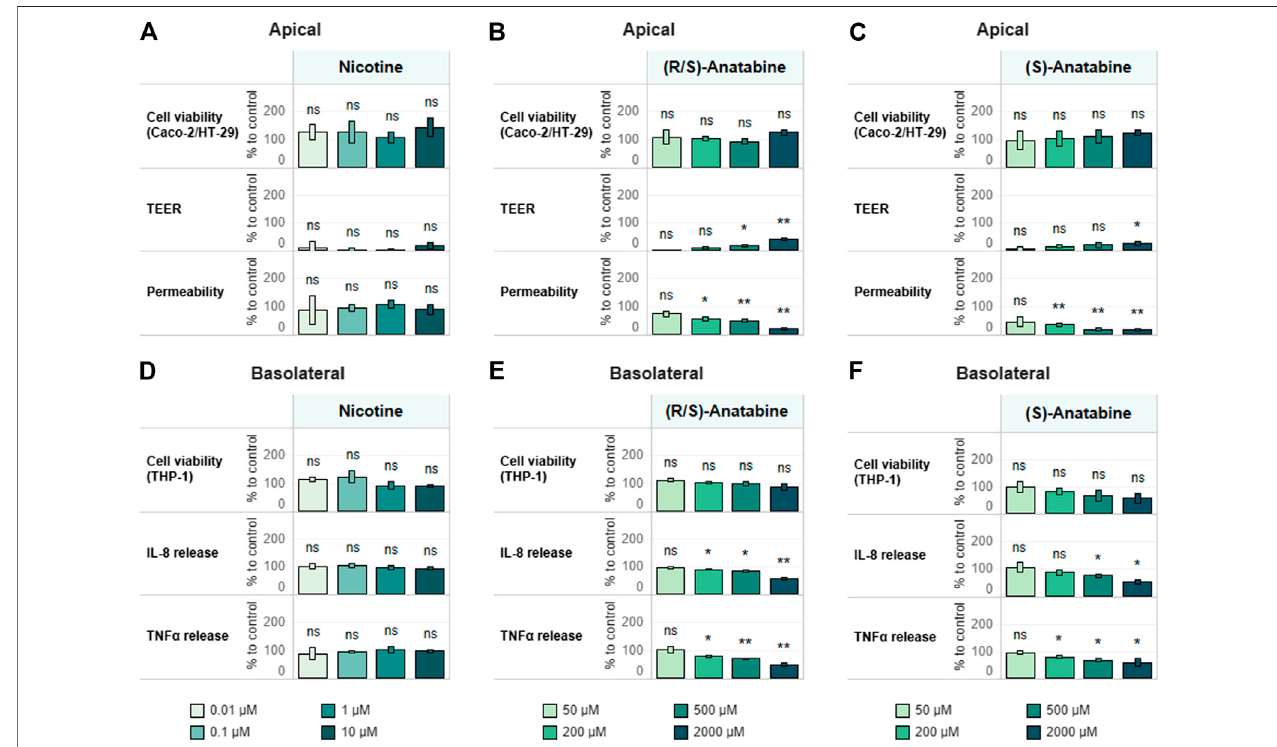
FIGURE 6 | Test item assessment. Tricultures were treated basolaterally with increasing concentrations of (A,D) nicotine (B,E) ( R / S )-anatabine, or (C,F) ( S )- anatabinefor6 handsubsequentlystimulatedwith10 ng/mlLPSfor18 h.TEER,epitheliallayerpermeability,cellviabilityofdifferentiatedCaco-2/HT29-MTXcells (A – C) and cytokine release and cell viability of differentiated THP-1 cells (D – F) were measured. TEER values are normalized to control (CTL; 100%) and LPS treatment (0%). PermeabilityisnormalizedbyusingLPStreatmentasthereference(100%).BasolateralIL-8andTNF α releaseareexpressedaspercentageofcontrol(cellstreated with LPS only; CTL; 100%). Cell viability values of Caco-2 – HT29-MTX cocultures and THP-1 cells are expressed as percentage of control (cells treated with LPS only; CTL; 100%). n (cid:2) 3independent experiments. Statistical differences between the reference compound-treated vs. LPS-treated-only cultures were determined by atwo- tailed t -test. * p ≤ 0.05; ** p ≤ 0.01; *** p ≤ 0.001; ns, p > 0.05. Abbreviations: LPS, lipopolysaccharide; TEER, transepithelial electrical resistance; TNF, tumor necrosis factor; IL, interleukin; CTL,